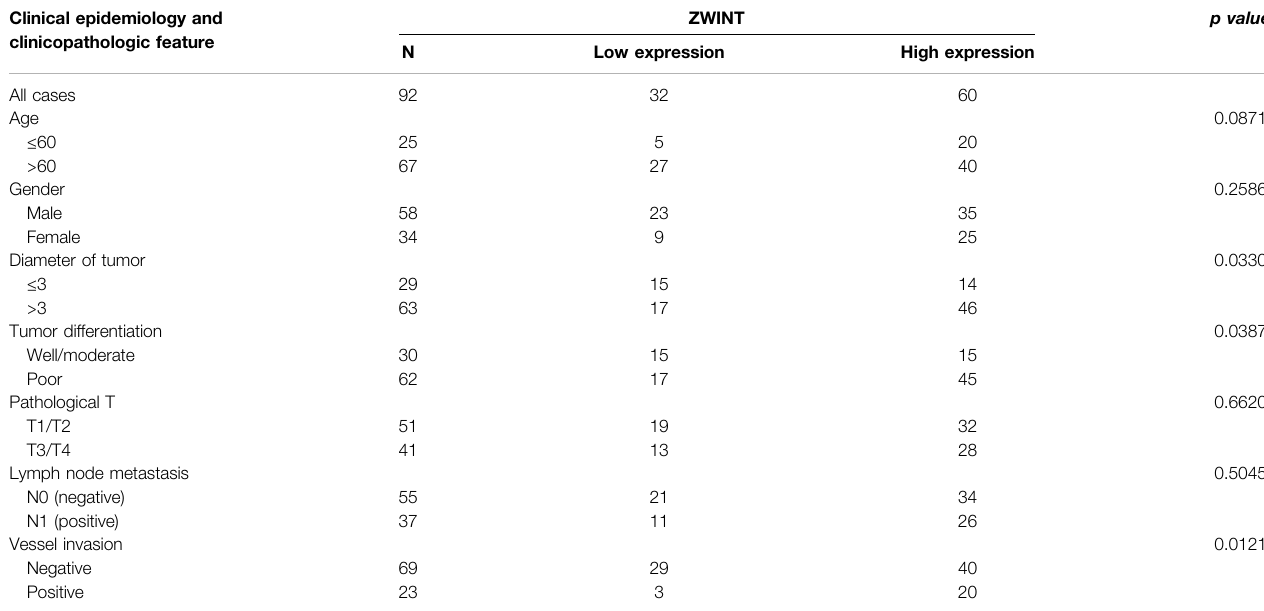
TABLE 3 | The General clinical pathological characteristics of pancreatic cancer patients. Clinical epidemiology and clinicopathologic